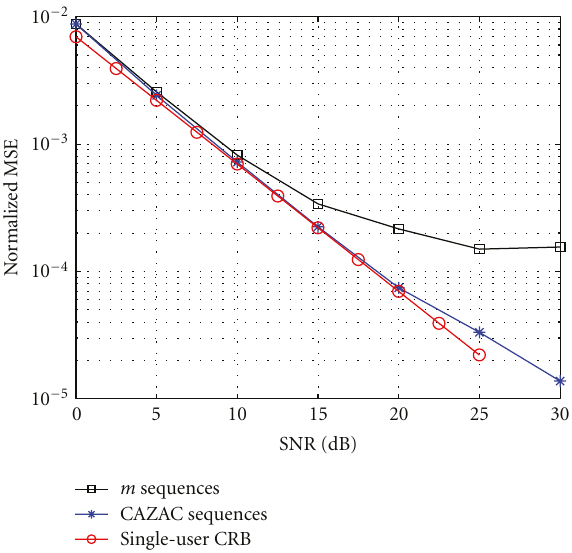
Figure 3: Comparison of CFO estimation using N = 31 Chu sequences and m sequence for uniform power delay